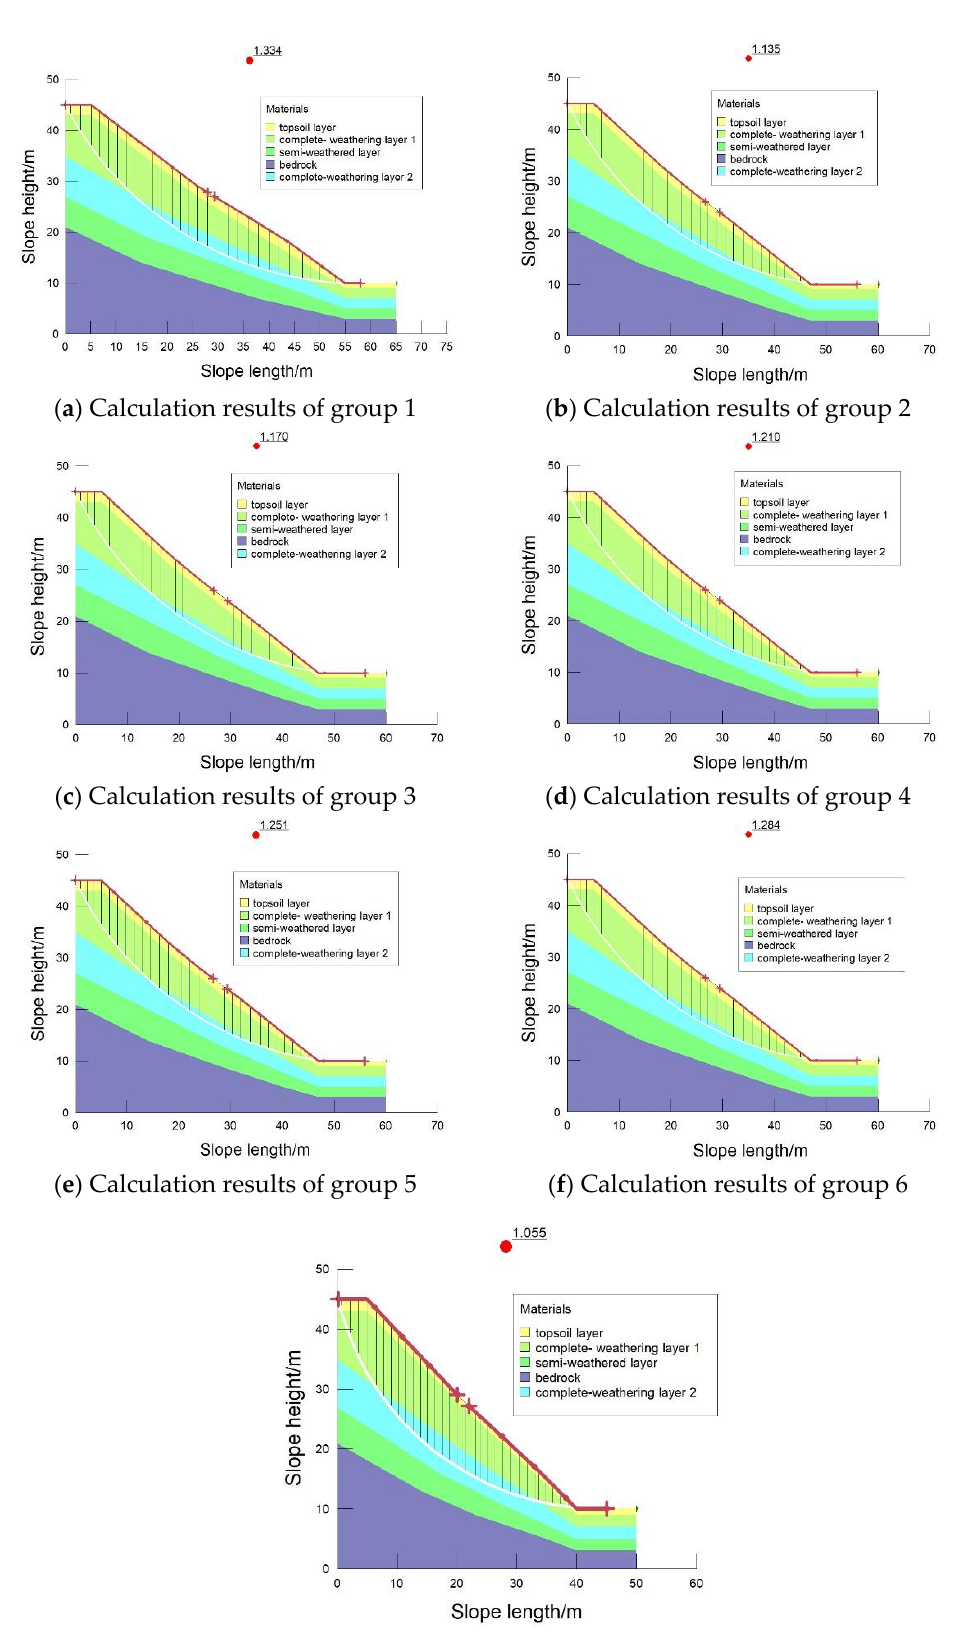
Figure 6. Calculation results for testing group 1 – 7. Table 3. Calculation results for sensitivity analysis.